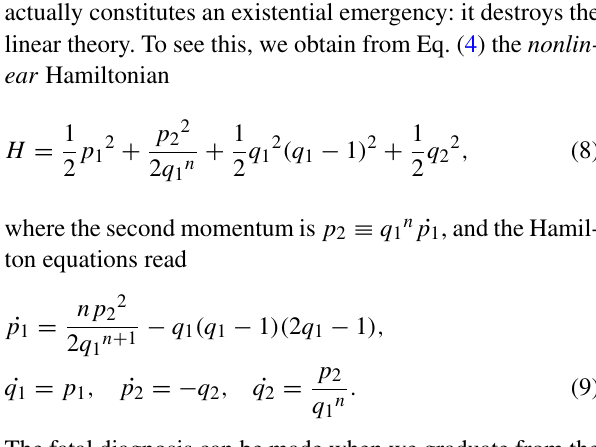
heart of the putative vacuum at q 1 = 0. On either side are split two new candidate vacua in red and